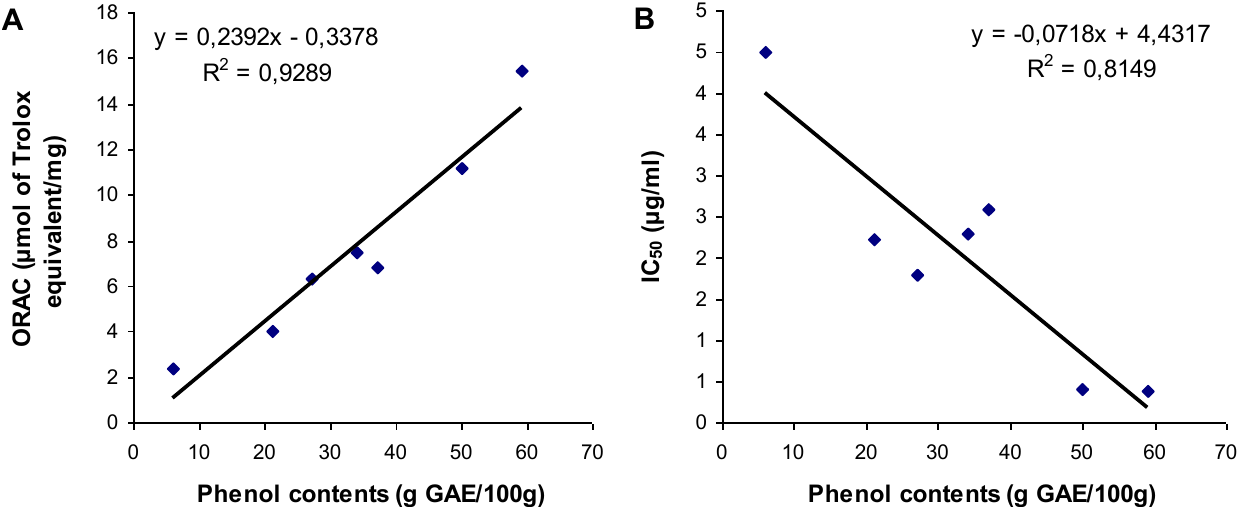
Figure 3. Relationship between ( A ) ORAC values and ( B ) IC of conifer bark, and their content in phenolic compounds. Solid lines represent linear regression curves. The regression coefficient ( R 2 ) and the equation of curves are